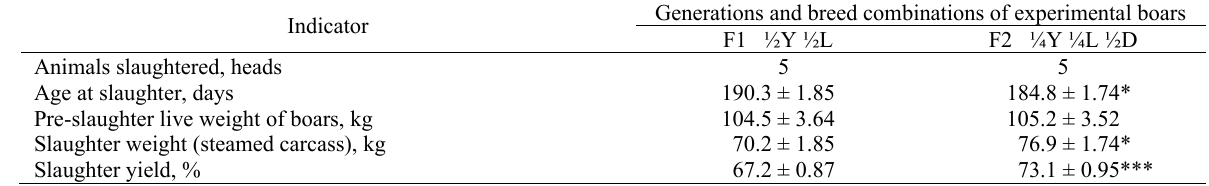
Results of the slaughter of crossbred boars